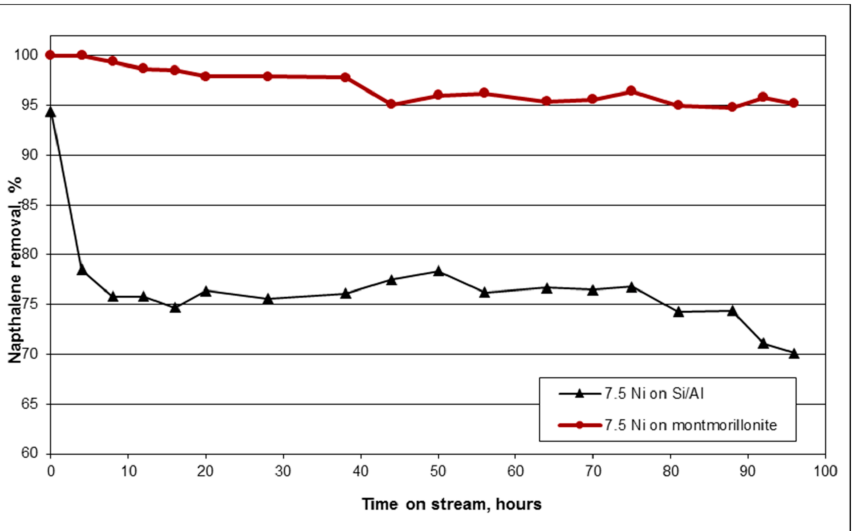
Figure 12. Naphthalene conversion with time on stream (T—750 ◦ C, S/C—5, GHSV—12,800 h − 1 , naphthalene loading—12 g/m 3